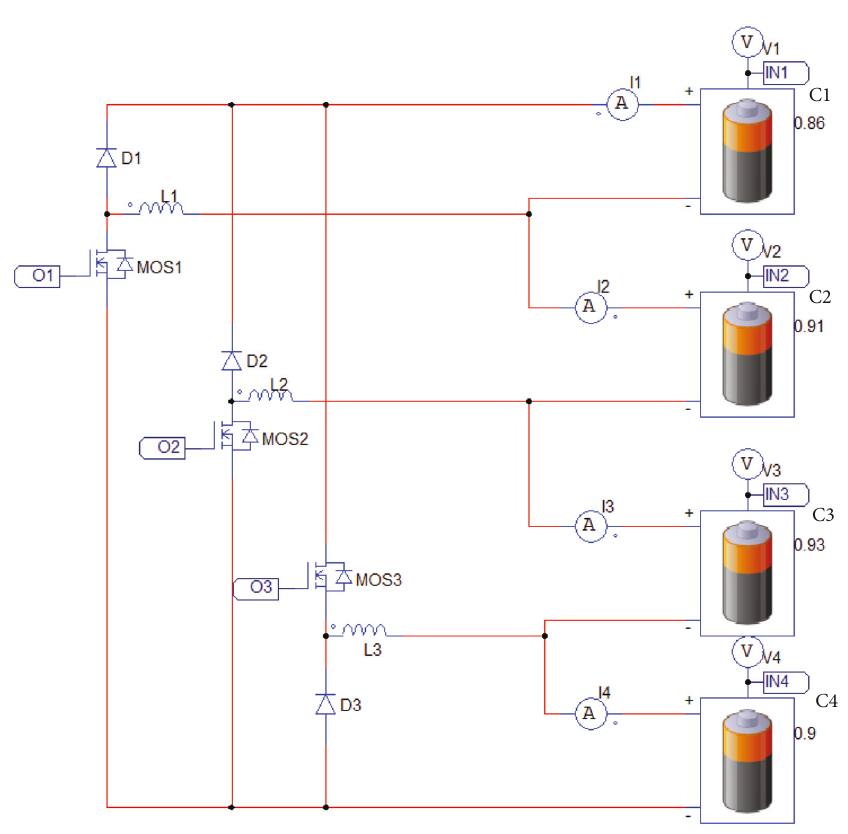
Figure 9: Schematic diagram of the energy equalization